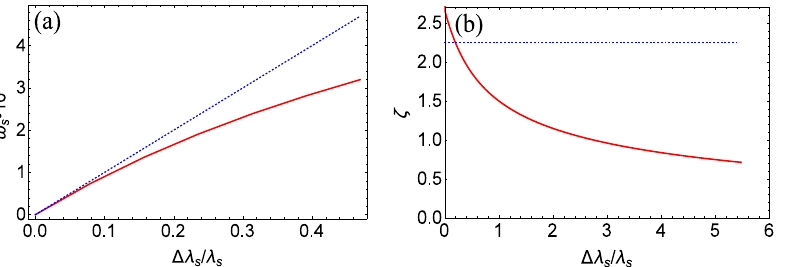
Figure 13. ( a ) Comparison between back-scattered photon frequency vs. ∆ λ s / λ s with (dot) and without (continuous) recoil contributions. ( b ) CBS cross section normalized to π r 2